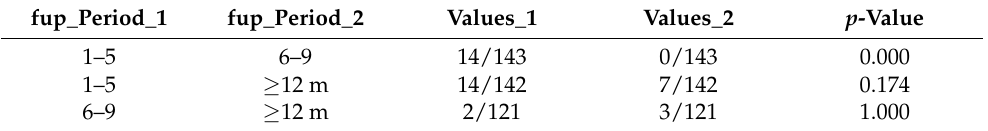
Table 5. Recovery dynamics for patients with repeated